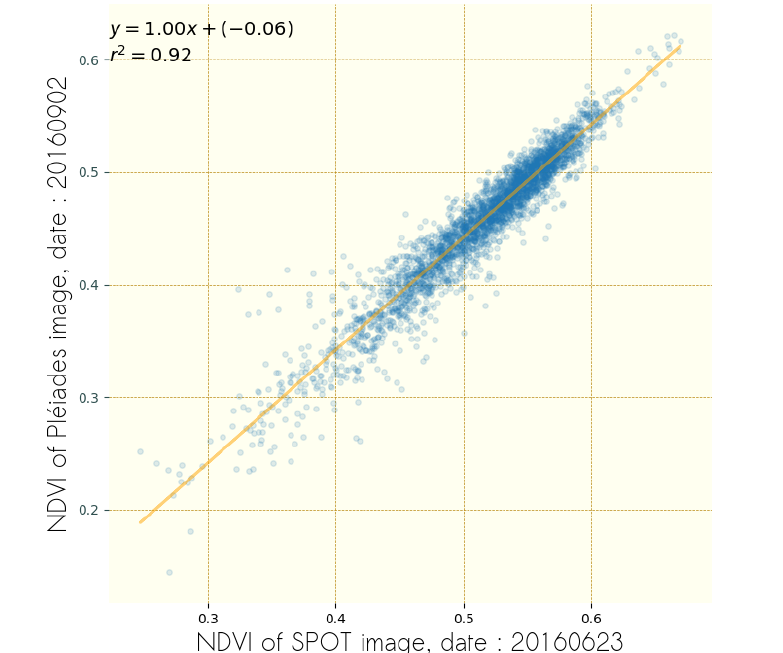
Figure A1. Scatterplot of mean NDVI values of windows computed for 6 m resolution of SPOT imagery and 2 m resolution Pléiades